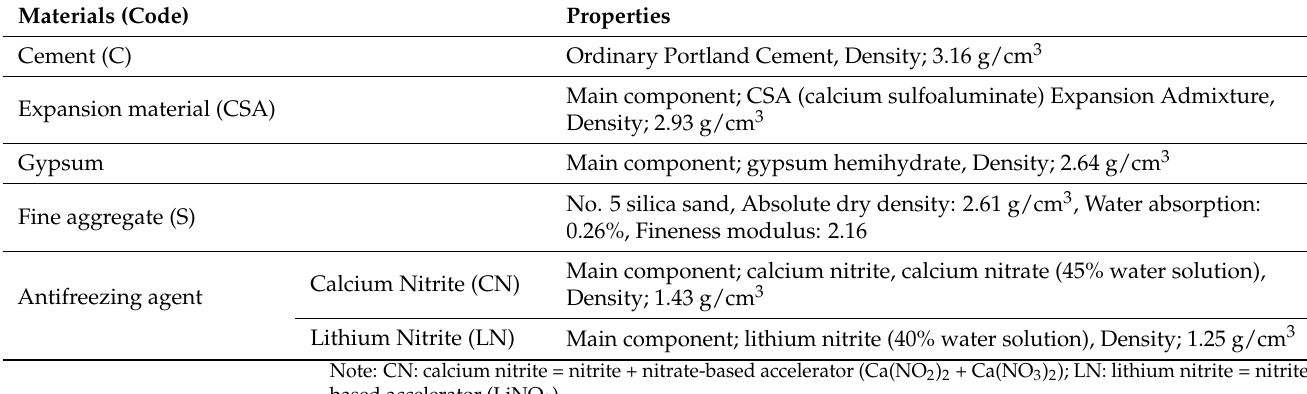
Table 1. Properties of the materials.